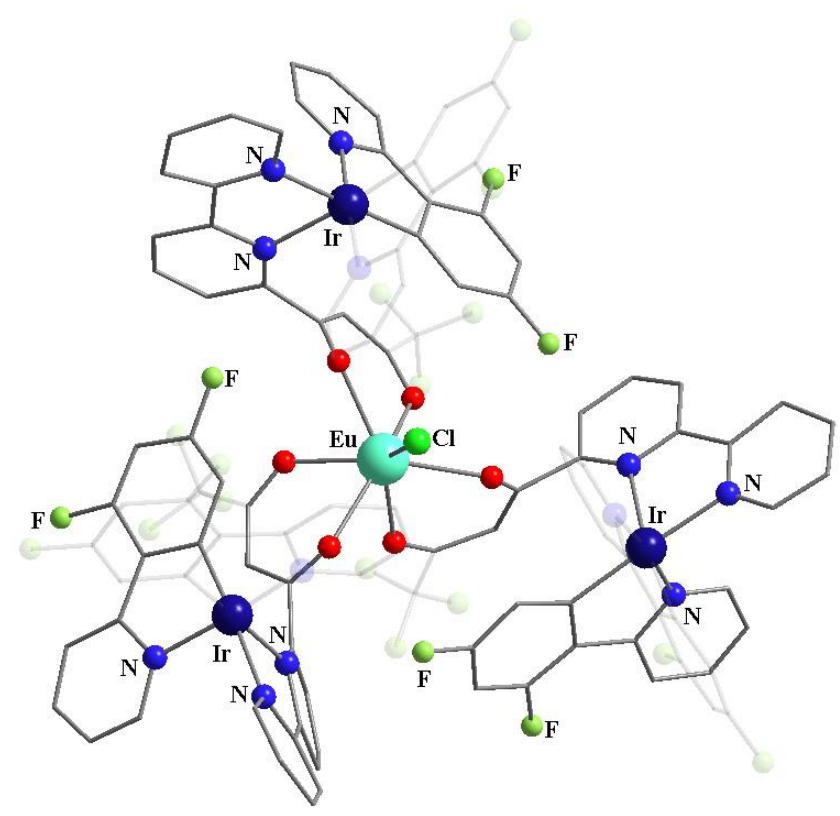
Figure 25. Molecular structure of 50 [52]. Hydrogen atoms have been omitted, some ligand groups are transparent for clarity. The cif has been retrieved from CCDC. CCDC number is 730200.